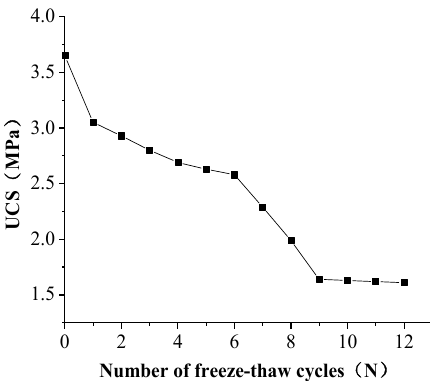
Figure 6. Effect of freeze–thaw cycles on compressive strength.